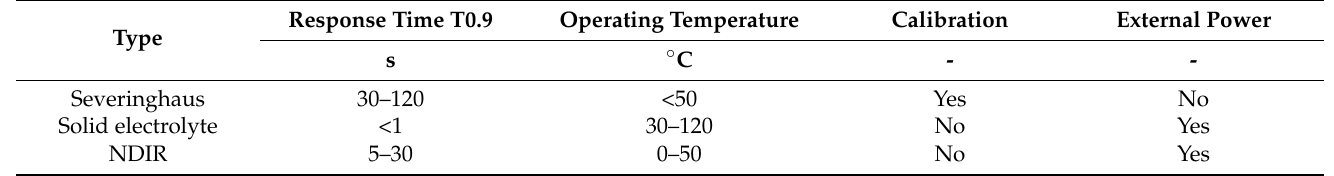
Table 10. Selected parameters of CO 2 concentration measurement